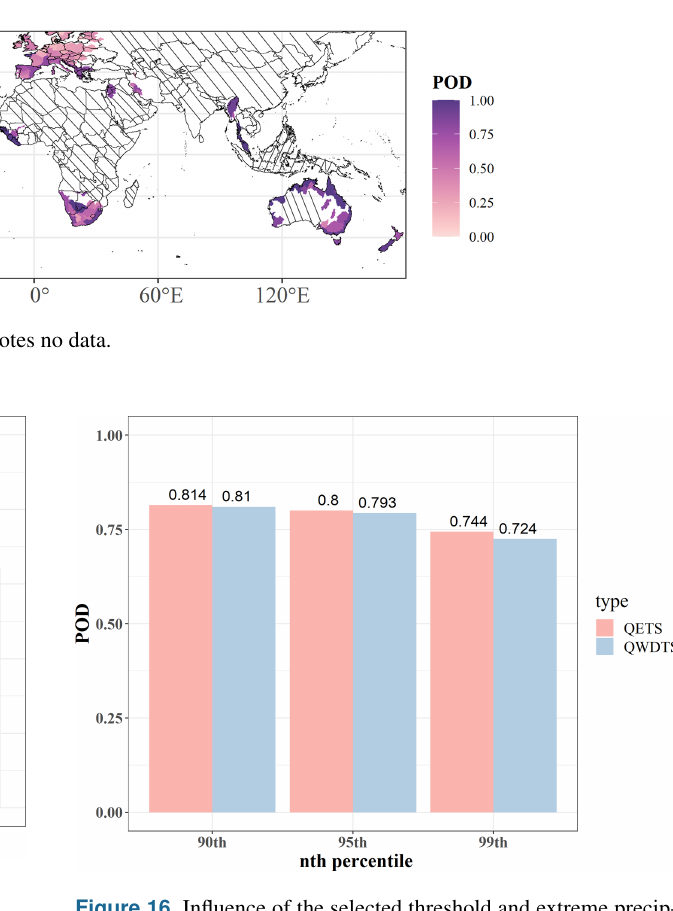
Figure 13. Flood event distribution in the Level 4 basins. Hatching denotes no data.